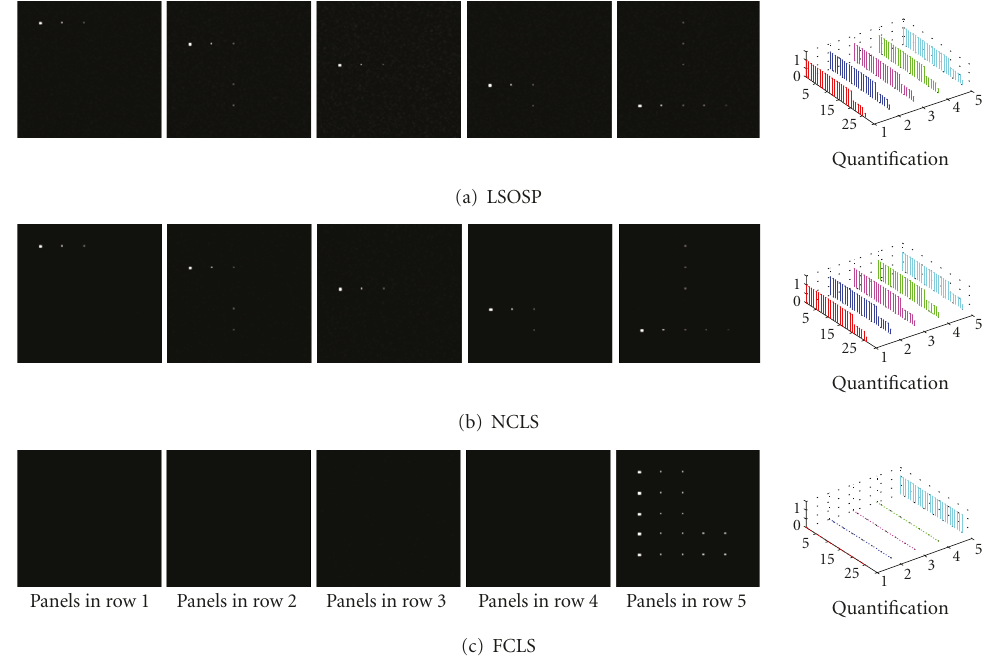
Figure 14: Results using LSOSP, NCLS, and FCLS to unmix TE with assuming signature knowledge in Figure